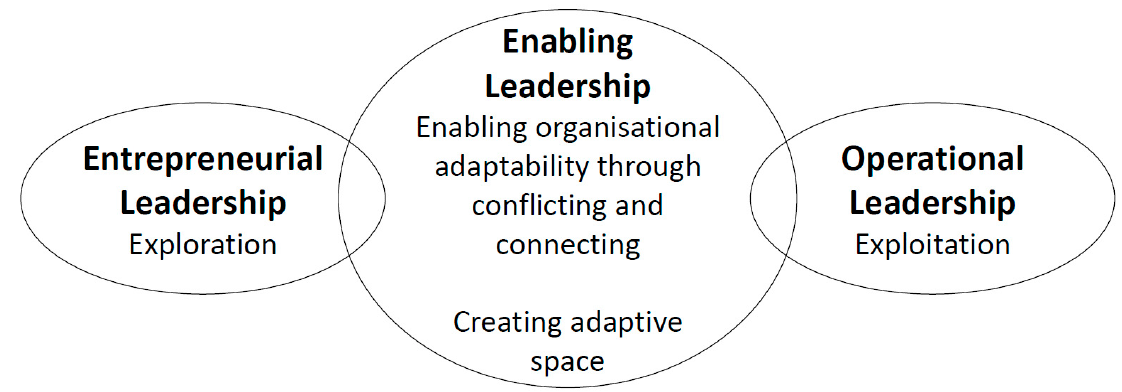
Figure 1. The model of leadership for organisational adaptability. Adapted from: (Uhl-Bien and Arena 2018).